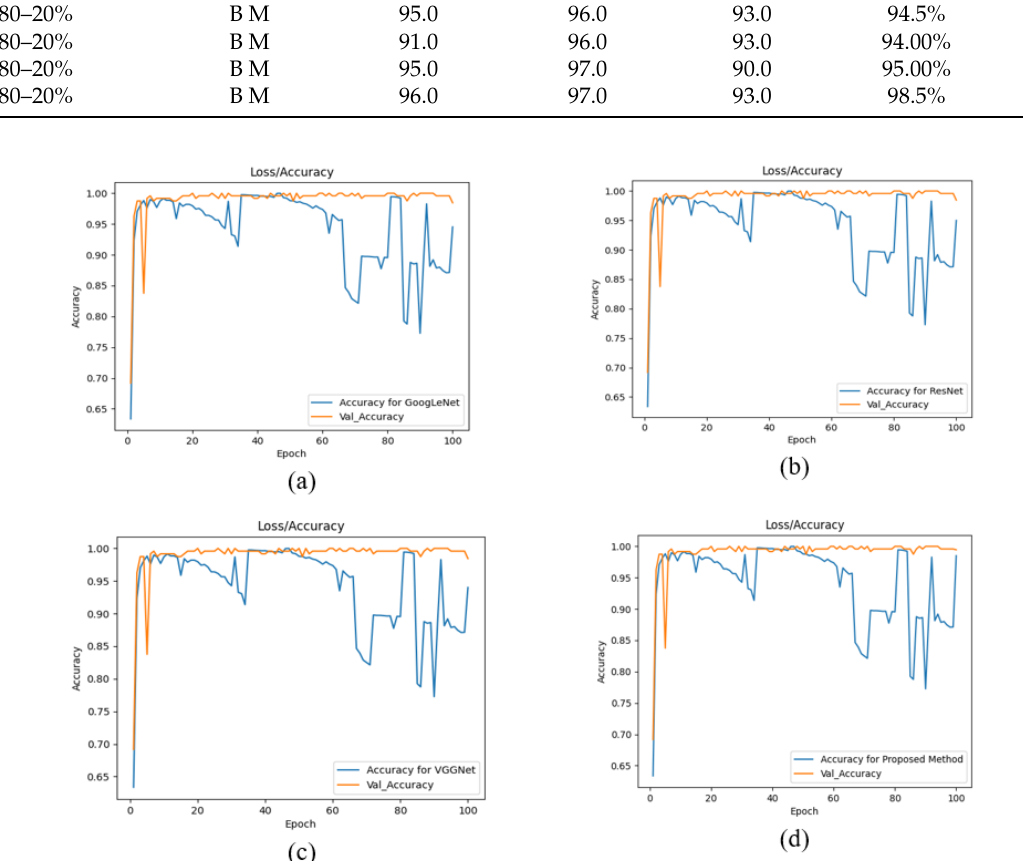
Figure 7. Analysis results with graphical representations—( a ) GoogLeNet ( b ) VGGNet ( c ) ResNet, and ( d ) the proposed